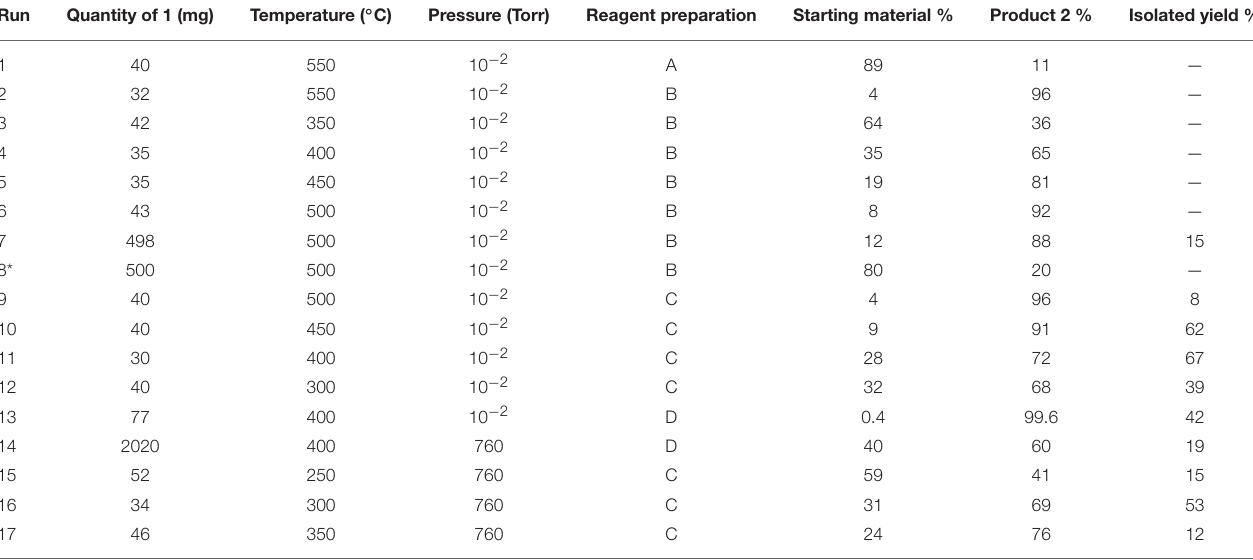
TABLE 1 | Results for gas-phase conversion of 1,3-dithiole-2-thione into 1,3-dithiol-2-one over molybdenum trioxide. Run Quantity of 1